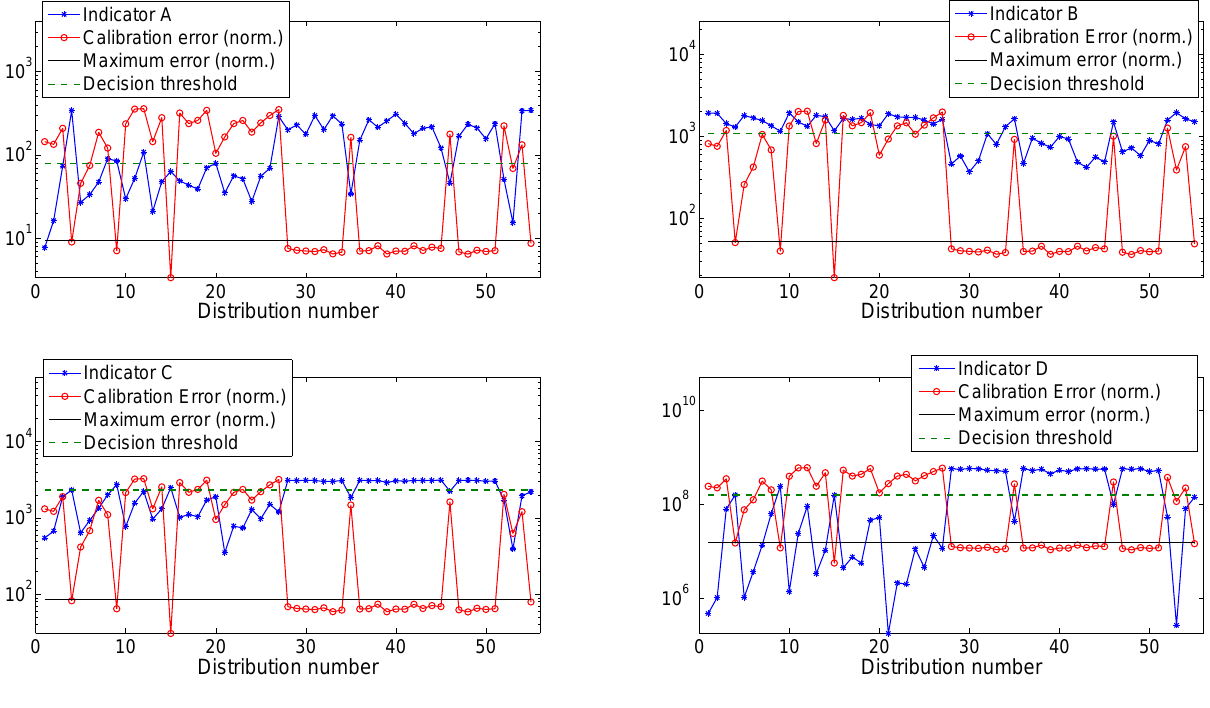
Figure 5. Dataset 2: Indicators vs . normalized calibration